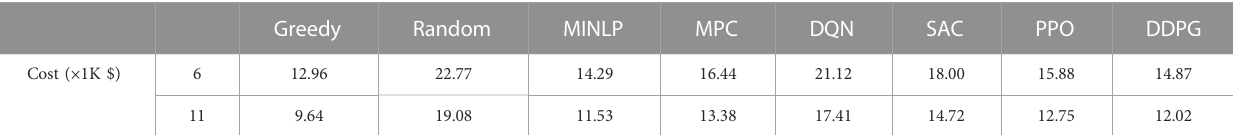
TABLE 5 Comparison of cumulative operating cost.